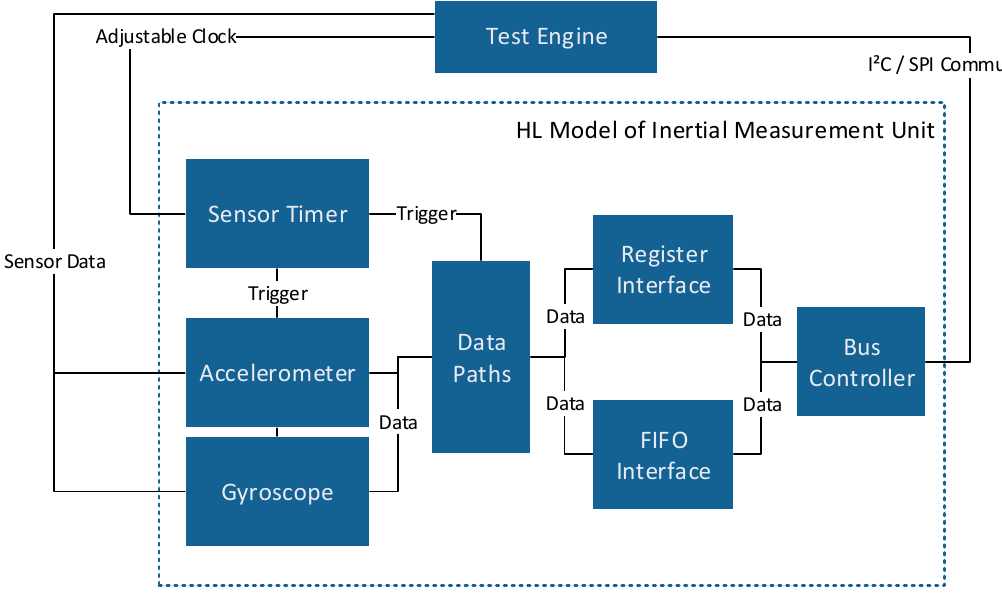
Figure 6. High level SystemC model of an inertial measurement